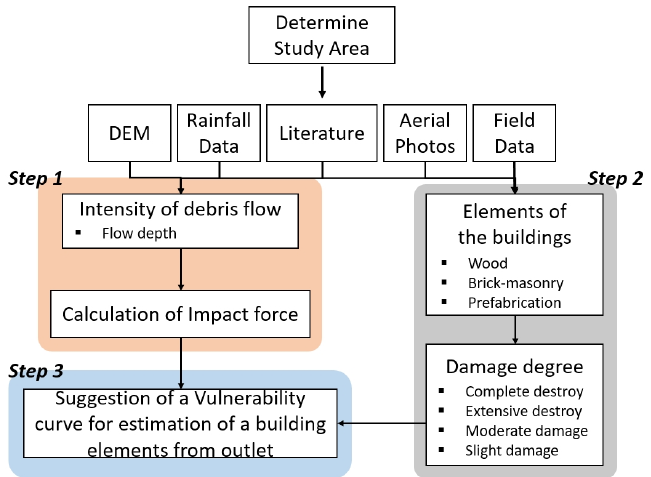
Figure 3. Flowchart for methodology of the study.